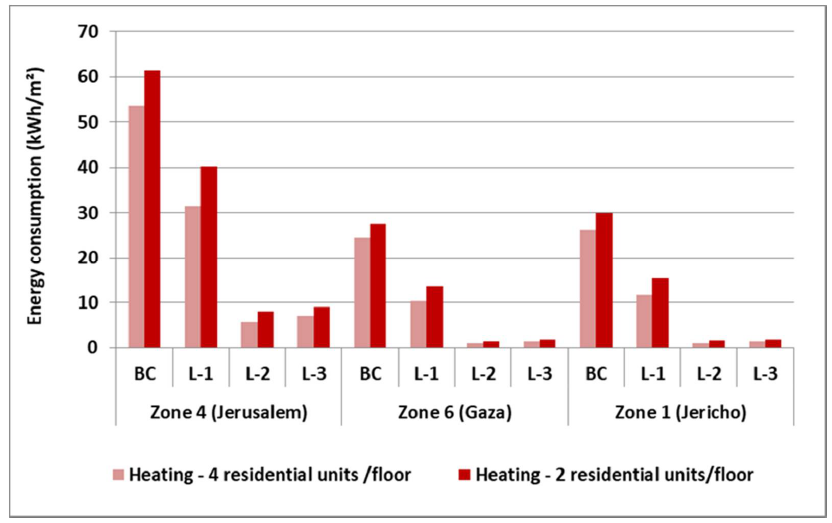
Figure 8. Comparing the saving in energy for heating from applying the retrofit plans on buildings with two residential units per floor area versus four residential units per floor area in different cli- matic conditions in Palestine.